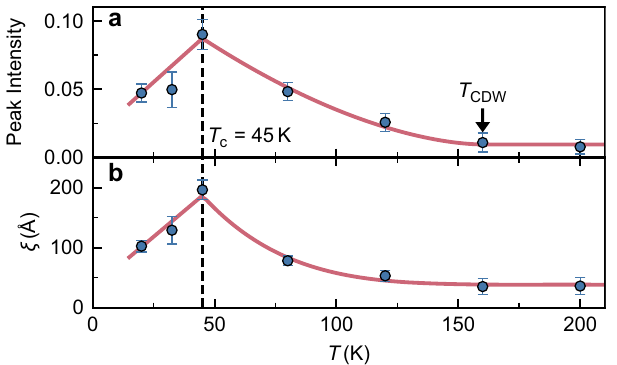
Fig. 4 Temperature dependence of CDW intensity and correlation length. The CDW peak intensity a and the a -axis correlation length b of the p = 0.25 sample. The dashed line marks T = 45 K and the arrow marks c T = 160 K. ξ ( T = T = 196 ± 17 Å and the result of the high CDW c ) temperature ξ fi t is 38 ± 7 Å. The correlation lengths are ξ = 1/ σ with no correction for instrument resolution and are therefore lower bounds. Error bars are standard deviations determined from least squares fi tting. CDW for three dopings at various temperatures. At T ≈ T c , the samples with dopings p = 0.23 and p = 0.25 exhibit peaks centred at δ = 0.309 ± 0.003 and 0.310 ± 0.003 r.l.u. respectively, while no Fig. 5 Charge density wave and Fermi surface reconstruction in Tl 2 Ba 2 CuO 6 + δ . a Fermi surface of Tl2201 (see Methods), with symmetry labels and volume corresponding to 0.25 doped holes (volume is 1 + p ). The dashed line is the antiferromagnetic Brillouin zone of the cuprates. CDW order (arrows) may cause a reconstruction yielding electron (red) and hole (green) pockets shown in b . c Phase diagram of overdoped Tl2201. CDW order is observed for doping p < p CDW ≈ 0.265 (dark green region). High-frequency quantum oscillations are observed for p ≥ 0.27 24 (sand coloured region and red squares) 24 . CDW existence is undetermined in light green region. CDW onset temperatures T CDW are shown by black circles, for p = 0.23 the open circle represents an upper bound. Red line is superconducting T c with samples measured here denoted by red fi lled circles. d The high- fi eld/low-temperature Hall number 21,51 (green squares). Lines of n H = p and n H = p + 1 are marked, with connecting dashed line. CDW peak intensity for T = T c (black circles). Dotted line is a guide to the eye passing through black circles and p CDW